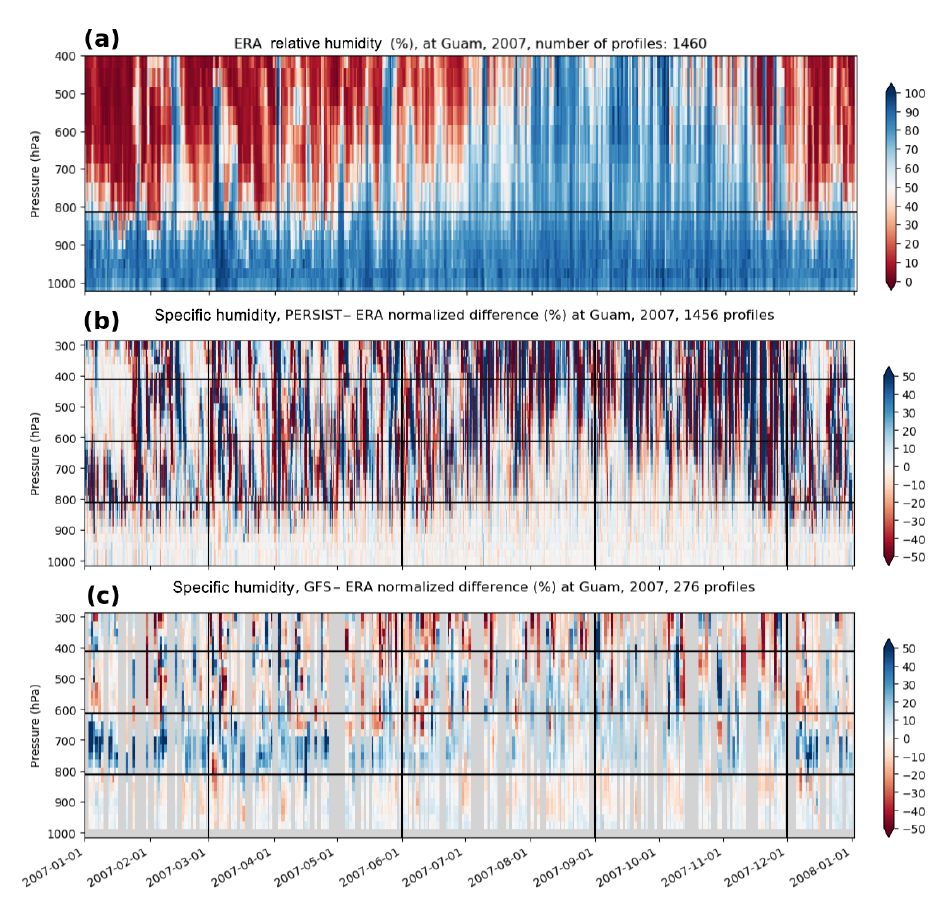
Figure 3. 2007 time series at Guam: (a) ERA relative humidity (%) with blue representing moist air and red representing dry air; (b) normal- ized difference of q (%) between PERSIST and ERA; (c) normalized difference of q (%) between GFS and ERA. The bottom panel shows that there are significant ( ± 50%) differences in the two model data sets. The color bar on the right indicates relative humidity (%) in (a) and specific-humidity normalized differences (%) in (b) and (c)